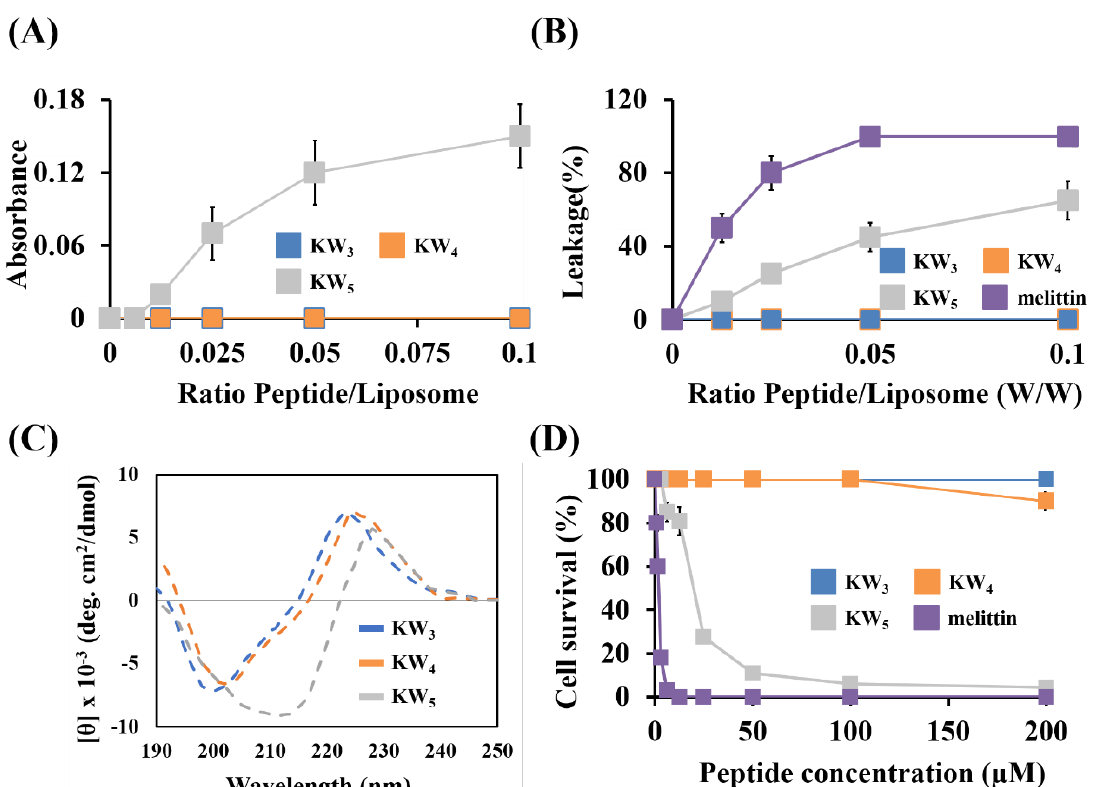
Figure 4. Cytotoxic activity of the KW n peptides. ( A ) LUV aggregation as a function of peptide concentration. Absorbance was measured at 405 nm. ( B ) Calcein leakage in PC–CH–SM (1:1:1, w / w / w ) vesicles. ( C ) CD spectra of peptides in the presence of PC–CH–SM (1:1:1, w / w / w ) SUVs. ( D ) Cytotoxicity of the peptides measured with HaCaT cells using the MTT assay. Error bars represent the SD (the averaged value for each test sample from experiments performed in triplicate). No error bar appears for some data points due to the small SD.